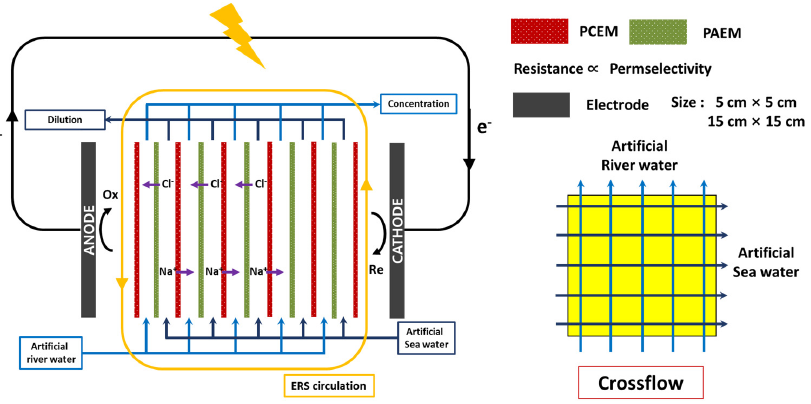
Figure 1. Schematic illustration of the reverse electrodialysis (RED) process according to the variation in properties of the ion exchange membrane as well as electrode size. ERS: electrode rinse solu ‐ tion. Table 1. Characteristics of pore ‐ filling cation exchange membranes (PCEMs) and pore ‐ filling anion exchange membranes (PAEMs) according to the composition of the electrolyte and crosslinking agent.